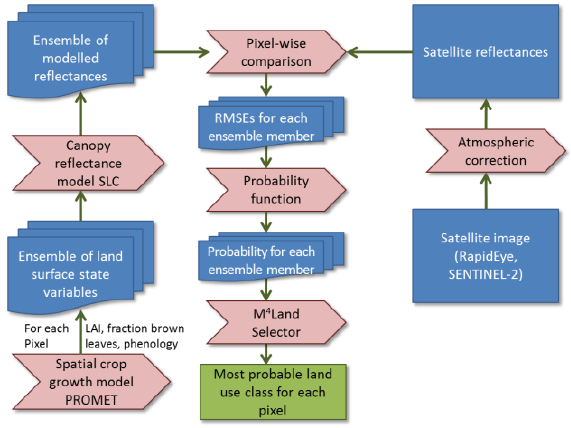
Figure 2. Flowchart illustrating the methodology of the model-supervised classification (Klug, 2014) Surface state variables as modelled by PROMET (green leaf area index, phenology and degree of maturity) are used as input to the spectral reflectance simulations with SLC. This is